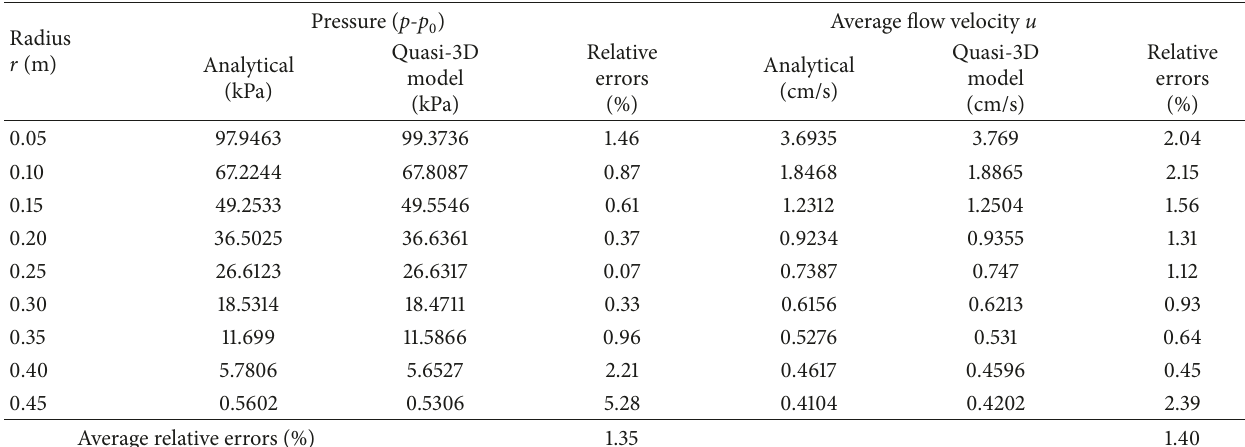
Table 9: Distribution of the pressure and average flow velocity over the radius at t = 50 s in Case